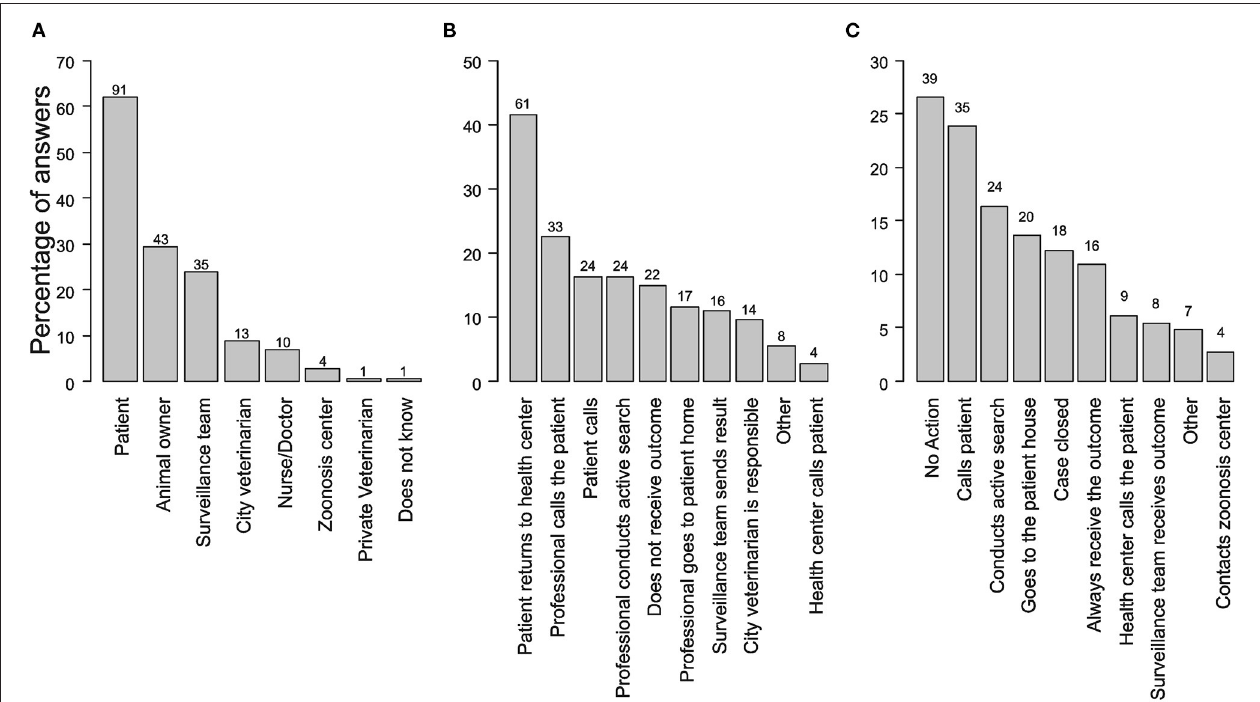
FIGURE 2 | Actions of health professionals related to a dog’s 10-day period observation required to assess its rabies status. (A) Person in charge of the observation period. Respondents could mention more than one criterion. (B) Reported actions allowing the health professional to receive the outcome of the 10-day observation period (C) Action taken by the health professional in the case that the observation outcome is not